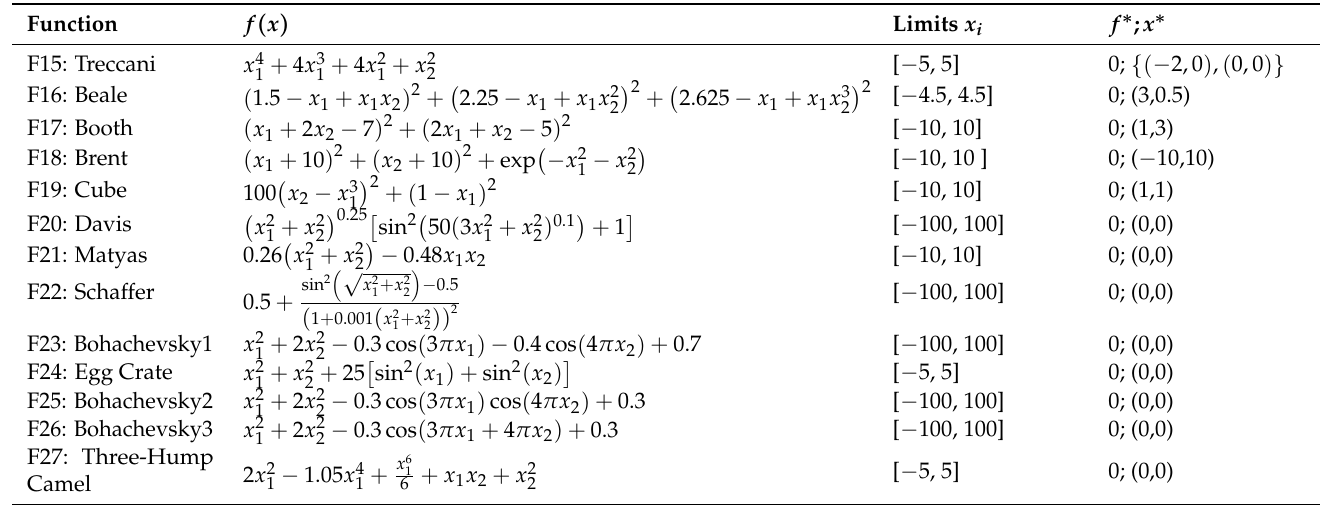
Table 4. D = 2 objective functions. The optimum value is denoted as f ∗ and x ∗ is the candidate